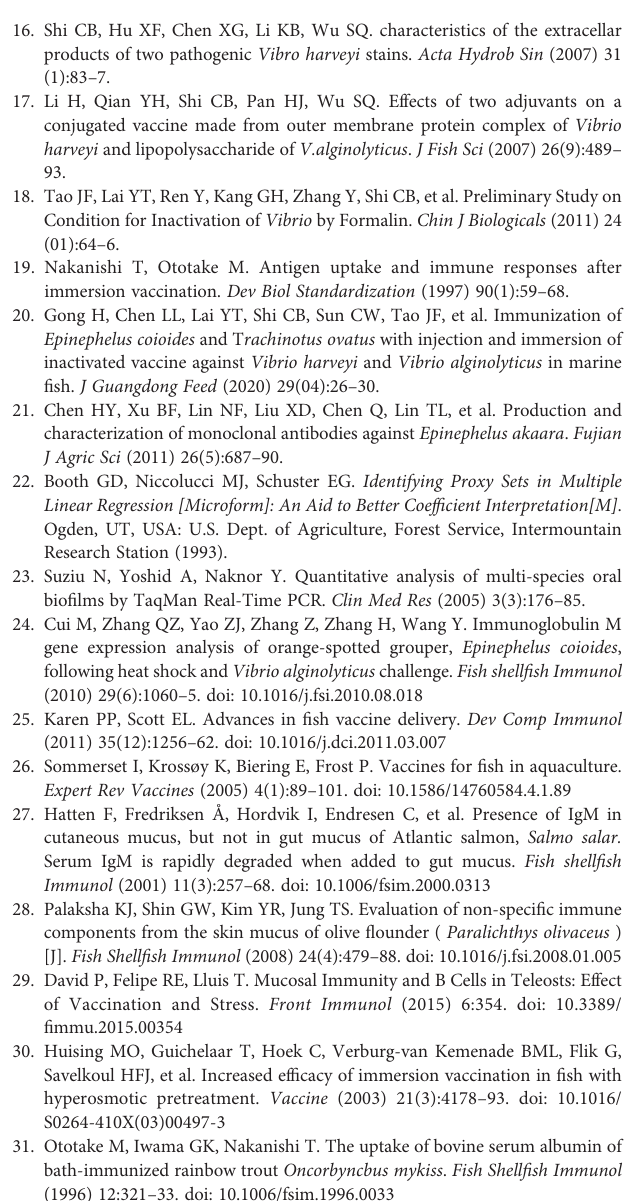
Supplementary Figure 1 | Agarose gel electrophoresis of total RNA isolated from fi sh tissues. Lanes 1 to 4. Carassius auratus and Lanes 5 to 8. Epinephelus coioides including samples from HK, spleen, gills and skin, respectively. Due to the large number of RNA samples, we only show the total RNA in several tissues extracted at a time point. Supplementary Figure 2 | Melting curves of b -actin (left, Tm: 92 ± 0°C) and IgM (right, Tm: 87 ± 0°C). The fusion curve analysis showed that the PCR products of b - ActinandIgMgenes showeda sharp single peak,andthere are noother stray